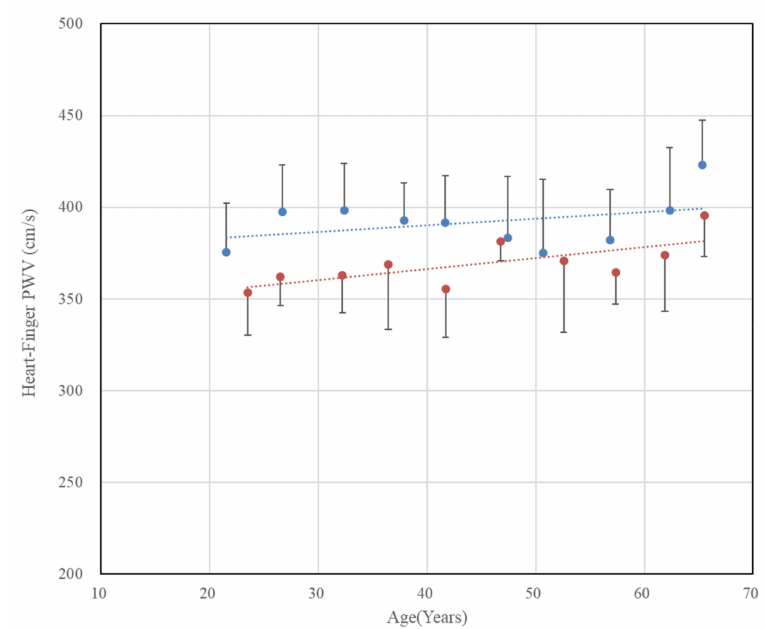
Figure 7. Chronological changes in heart–finger pulse wave velocity in both genders. The error bars represent the standard deviations (blue: males, r = 0.37, p = 0.286, red: females, r = 0.71, p =